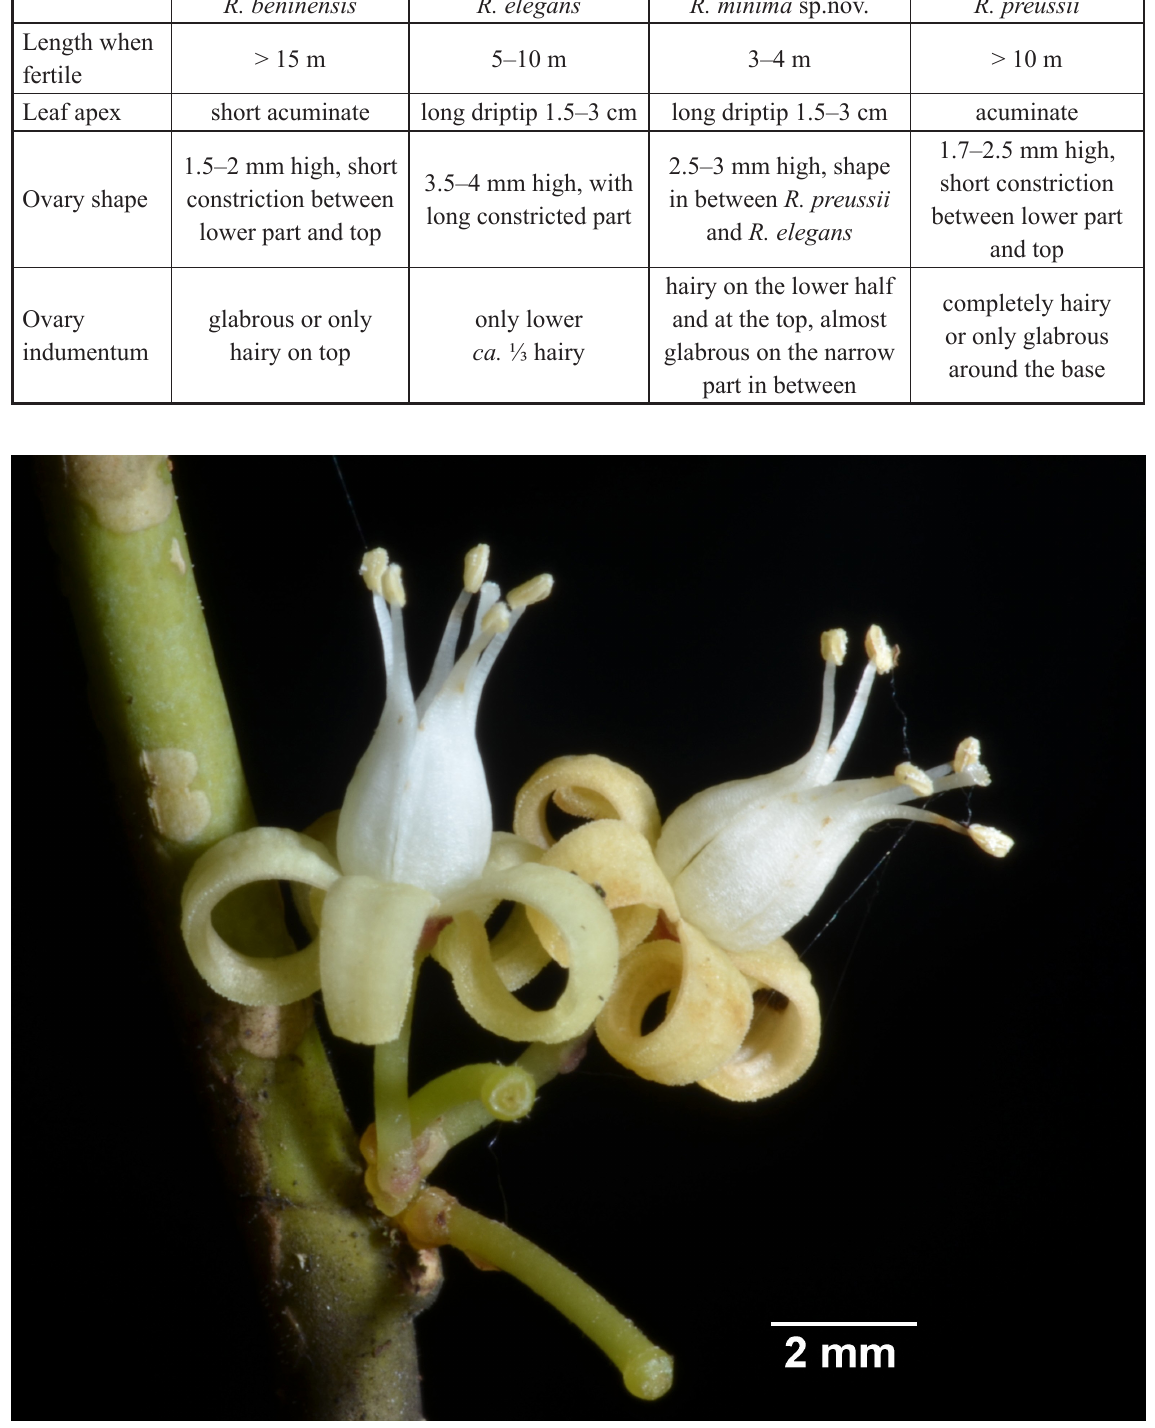
Fig. 2. Rhaphiostylis preussii Engl. showing flowers with the flattened filaments closing around the ovary while the petals are bending down. Photograph by Ehoarn Bidault (Missouri Botanical Garden) from Bidault 786 (MO) from